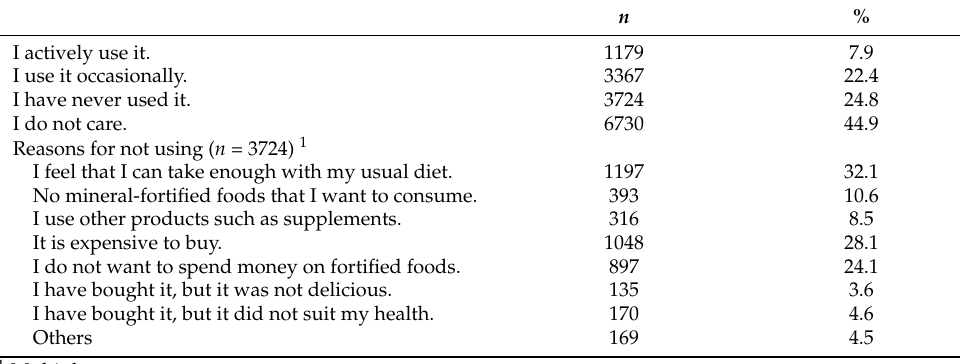
Table 2. The prevalence of mineral-fortified food usage and reasons for non-usage.